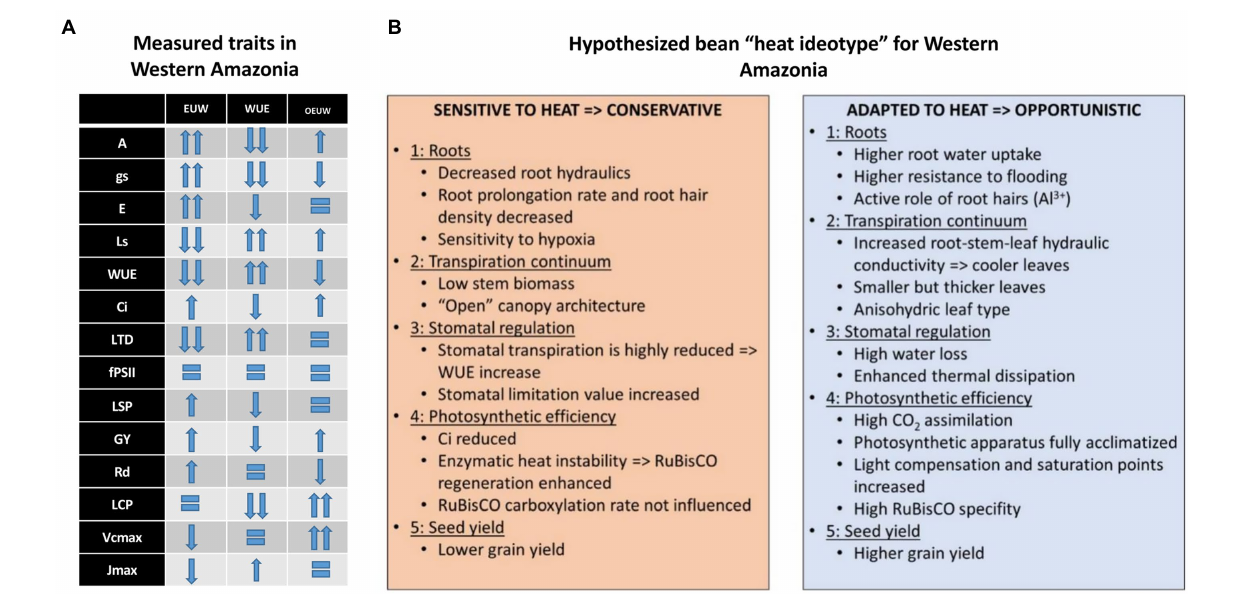
FIGURE 9 | The overview of the measured physiological traits (A) in heat-treated beans in Western Amazonia for three different genotype groups and suggested bean heat ideotype (adapted to heat) based on published and hypothesized results (B) . Gas exchange parameters at leaf level: stomatal conductance ( gs , mmol H 2 O m − 2 s − 1 ), transpiration rate ( E , mmol H 2 O m − 2 s − 1 ), photosynthetic Water Use Efficiency ( WUE , mmol CO 2 mol − 1 H 2 O), sub-stomatal CO 2 concentration ( C i , μ mol mol − 1 ), stomata limitation value ( glim ), leaf temperature differential ( LTD ), light-saturated maximum net carbon assimilation rate ( A max , μ mol CO 2 m − 2 s − 1 ), light compensation point ( LCP, μ mol m − 2 s − 1 ), dark respiration rates ( R d , μ mol CO 2 m − 2 s − 1 ), light saturation point ( LSP, μ mol m − 2 s − 1 ), and apparent quantum efficiency